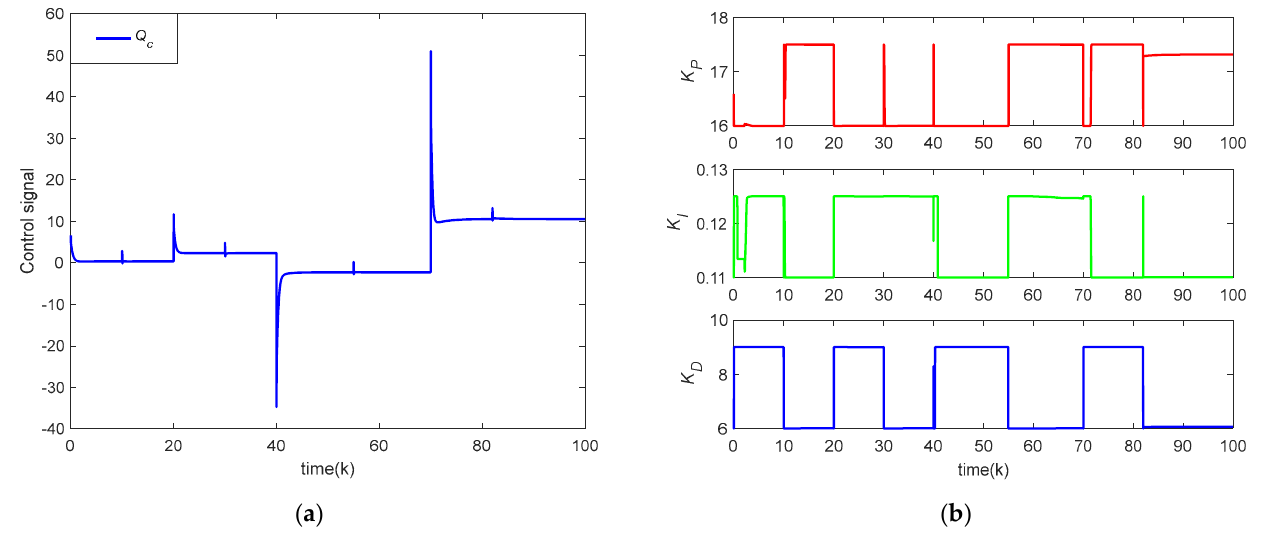
Figure 11. Tracking results of the ER ‐ PID controller with a multi ‐ point perturbation.